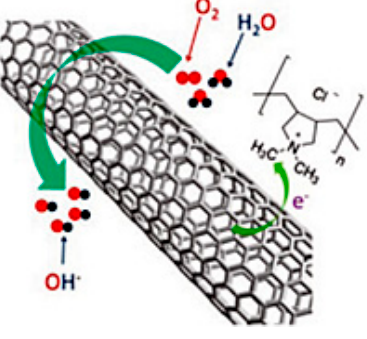
Figure 5. Illustration of the charge transfer process and ORR on poly(diallyl dimethyl ammonium chloride) (PDDA)-CNT. (Reprinted with permission from Ref. [115]. Copyright (2011) American Chemical Society).